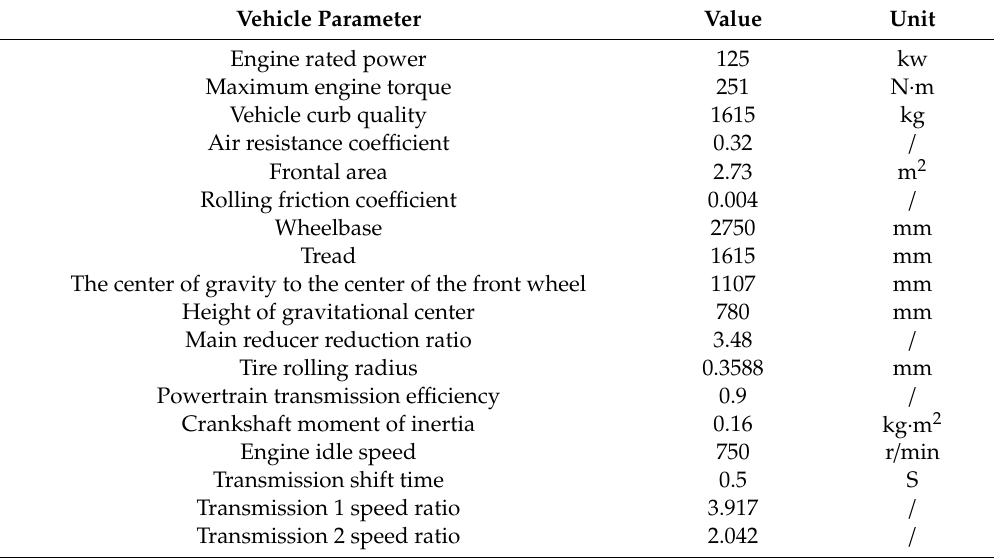
Table 1. Main vehicle parameters.